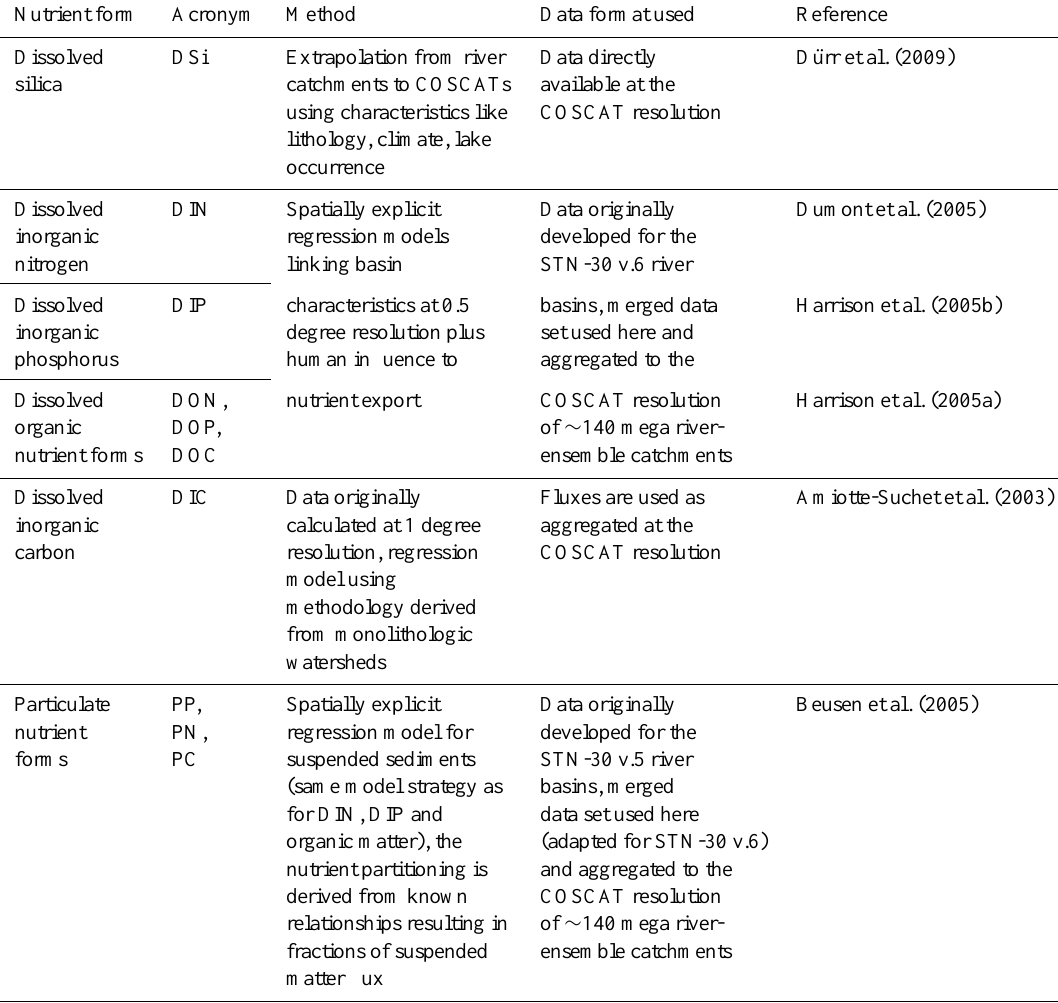
Table 1. Data sources for nutrient forms used here as riverine